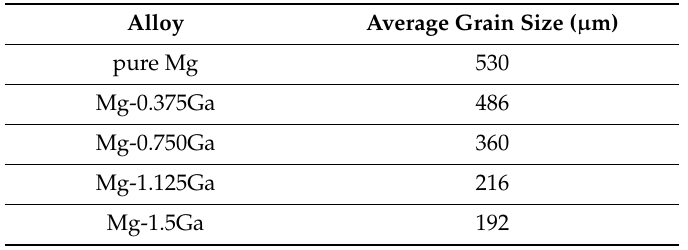
Table 2. Average grain size of pure Mg and as-cast Mg-Ga alloys.